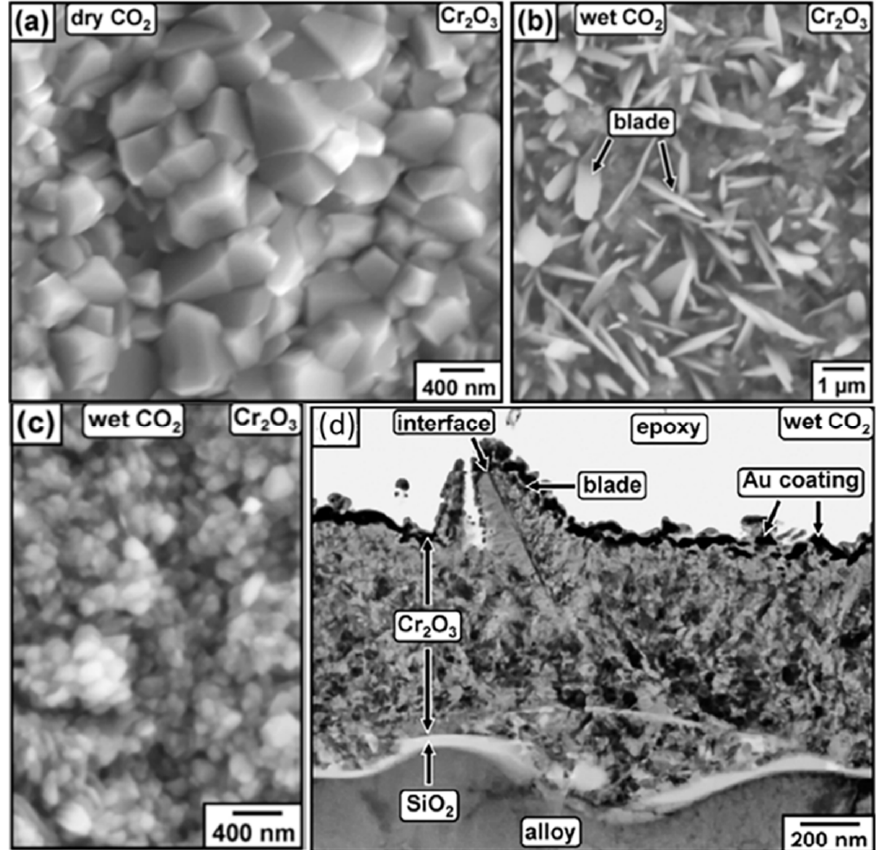
Figure 12. SE-SEM top views of Fe20Cr0.5Si model alloy (ground with 1200 grit paper) after reaction for 240 h in 818 °C/1 bar: ( a ) Ar-20%CO 2 and ( b ) Ar-20%CO 2 -20%H 2 O. ( c ) High magnification image of the solid surface between blade-shaped whiskers in ( b ). ( d ) BF-TEM cross-sectional images of Fe20Cr0.5Si model alloy (ground with 1200 grit paper) after reaction for 240 h in 818 °C/1 bar Ar-20%CO 2 -20%H 2 O [81]. Reproduced with permission from Elsevier.